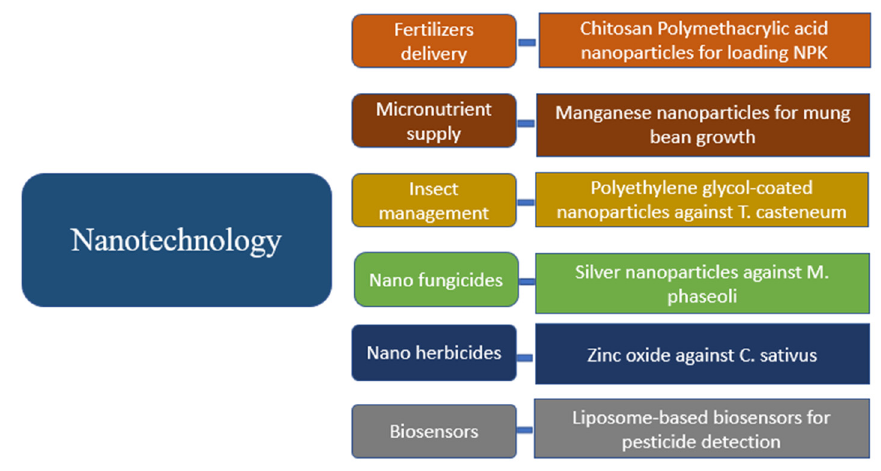
Figure 1. Role of Figure 1. Role of nanotechnology.